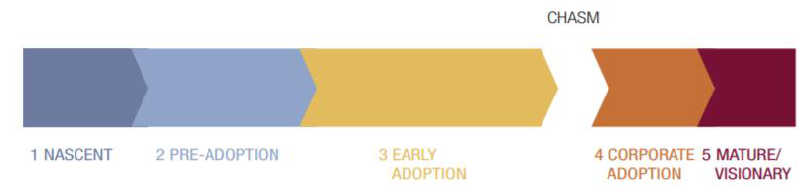
Fig. 3 Level of maturity within the TDWI Big Data Maturity